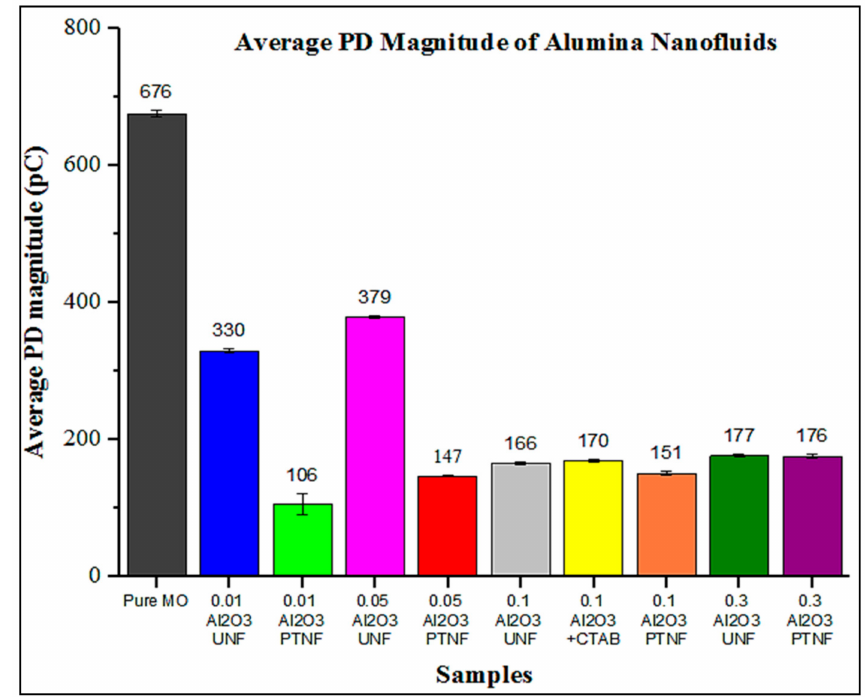
Figure 12. Average PD magnitude (pC) of all alumina nanofluid samples.